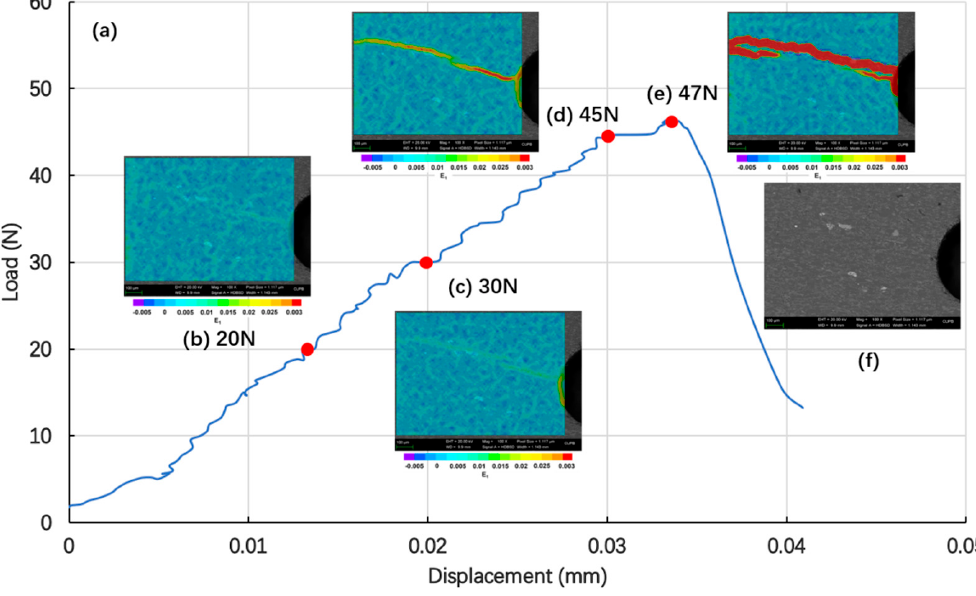
Figure 7. Cracking process in group ST − 2: ( a ) load–displacement curve for group ST − 2; ( b ) E 1 cloud chart at a load of 20 N; ( c ) E 1 cloud chart at a load of 30 N; ( d ) E 1 cloud chart at a load of 44 N; ( e ) E 1 cloud chart at a load of 47 N and ( f ) zoomed out SEM image of the crack.